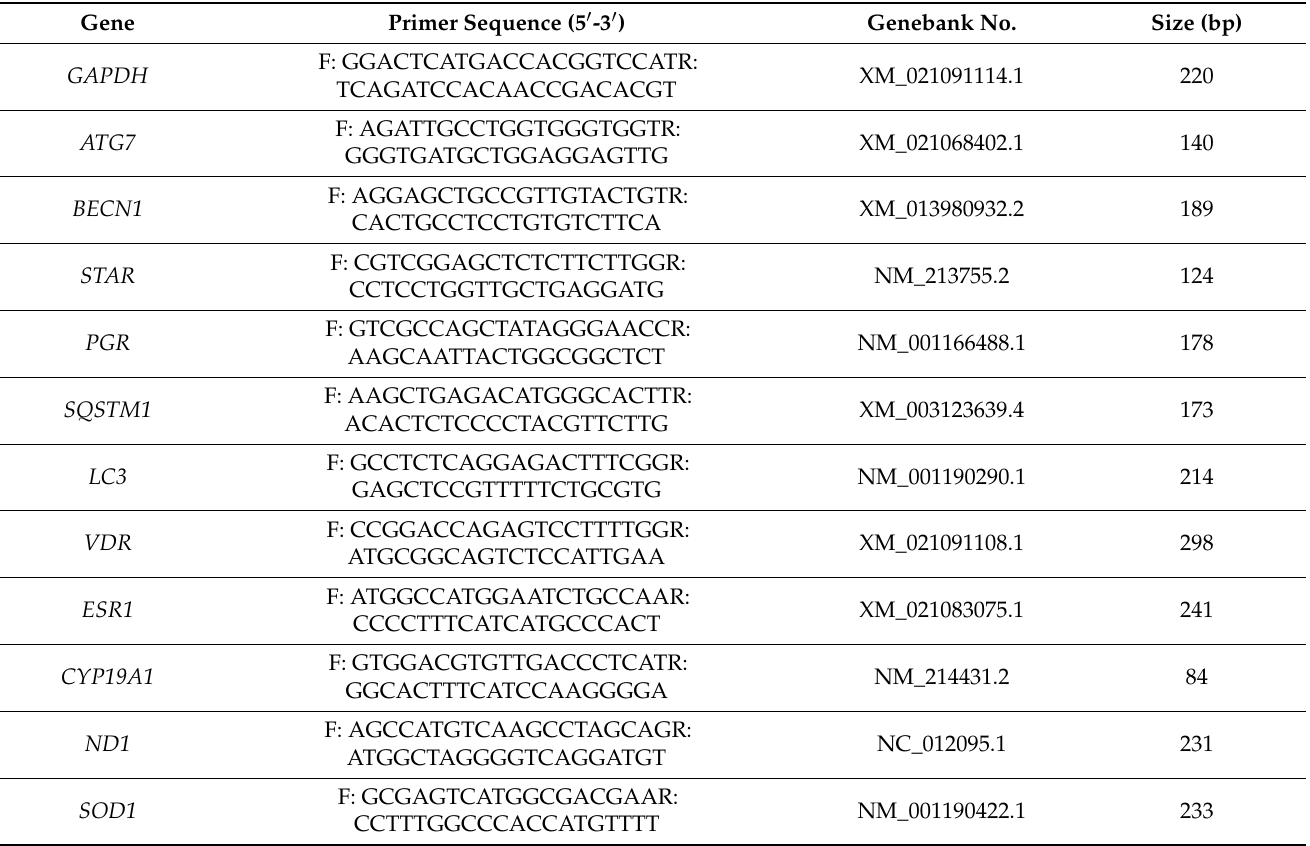
Table 1. Porcine-specific Q-PCR primer